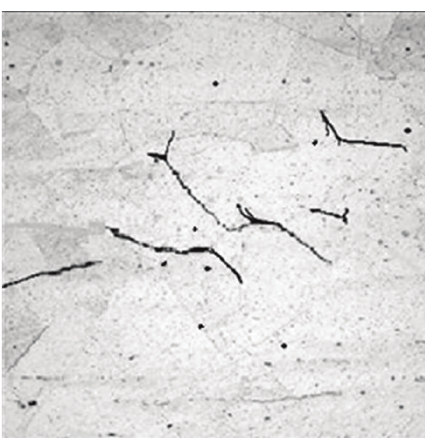
Figure 5: Austenitic stainless steel type 304LN (80 𝜇 m) showing a classical chloride stress corrosion cracking and small size pits.